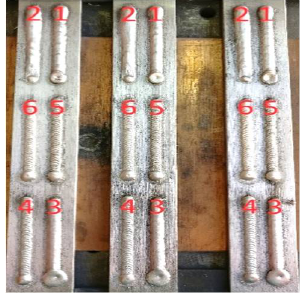
Figure 2. Sequence of the first six welding programs carried out.